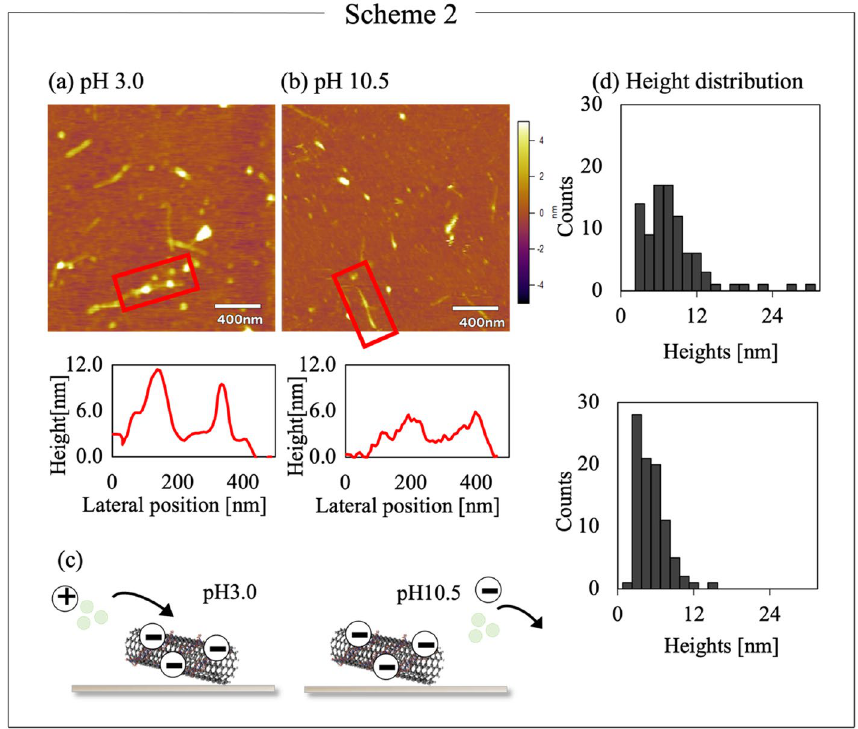
Figure 3. AFM images and height histograms of the DNA–SWNTs mixed with the papain at ( a ) pH 3.0 and ( b ) pH 10.5. The experiments were analyzed in AFM liquid condition after successively dropping the DNA– SWNT and papain solutions onto the AP-treated mica substrates. ( c ) Interactions of the papain molecules and DNA–SWNTs at pH 3.0 and 10.5. ( d ) The histograms illustrate the height data corrected with those of the gold